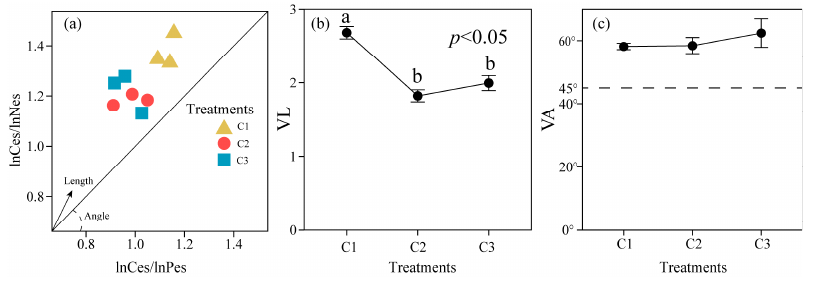
Figure 3. The vector characteristics of enzyme activity in compound soils with different feldspathic sandstone-to-sand ratios. ( a ) Vector analysis, ( b ) vector length (VL), ( c ) vector angle (VA). Ces: C-acquiring enzymes activities; Nes: sum of N-acquiring enzymes activities; Pes: P-acquiring enzymes activities. C1, C2, and C3 represent ratios of feldspathic sandstone to sand of 1:5, 1:2, and 1:1. Different lowercase letters represent significant differences at the 0.05 level. Error bars are the standard errors ( n = 3).